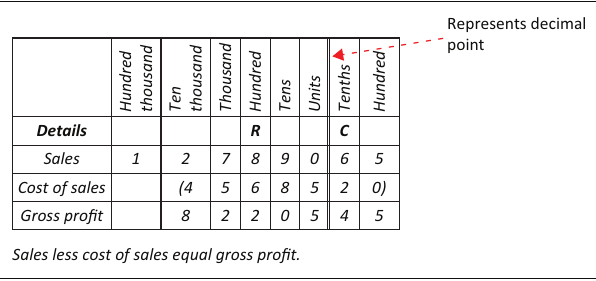
FIGURE 2: Positioning numbers in a place-value numerical